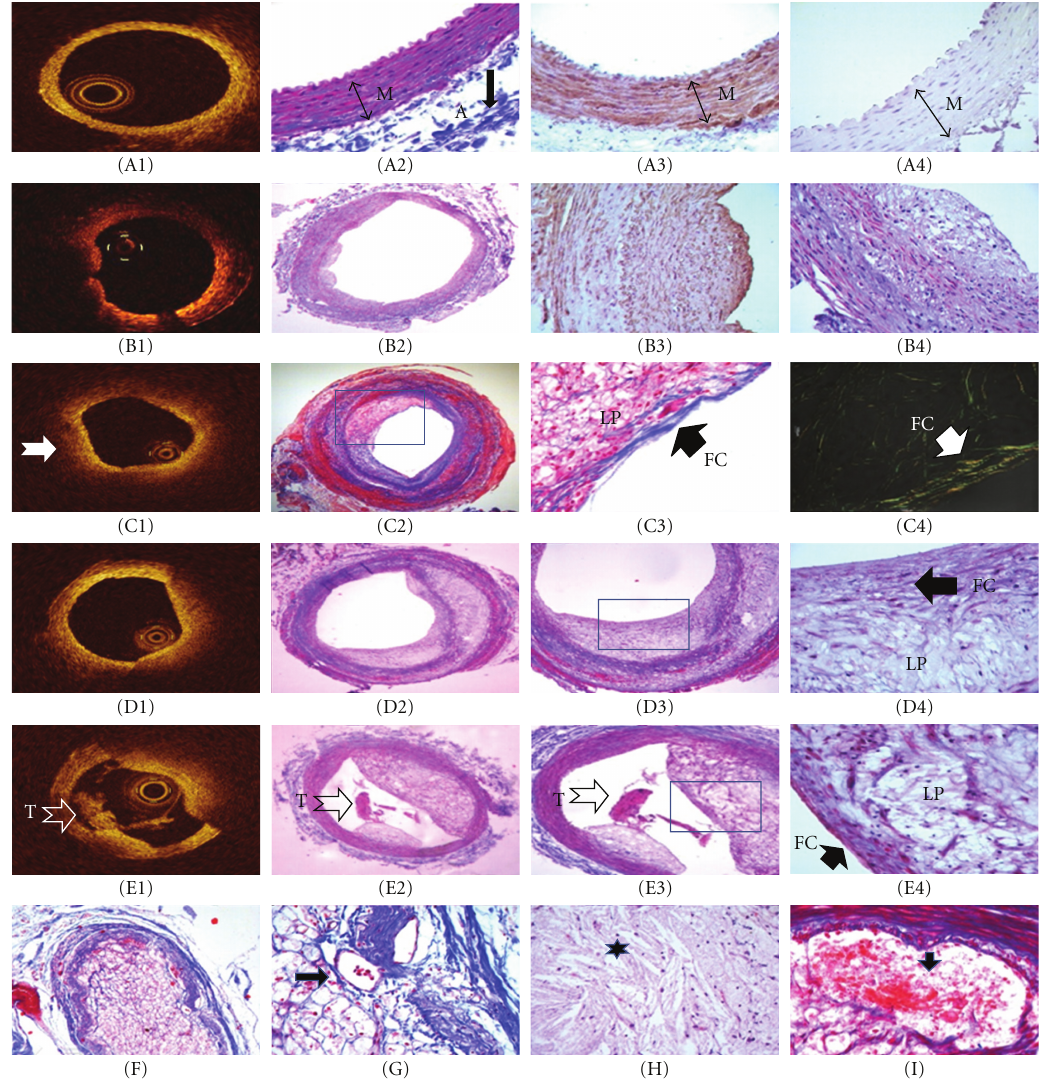
Figure 3: Histological features of normal and atherosclerotic lesions in rabbits and the corresponding OCT images. (A1)–(A4): OCT and histology images of a normal vessel; (B1)–(B4): type-III plaque; (C1)–(C4): type-IV plaque. D1–D4: type-V plaque; (E1)–(E4): type-VI plaque; (F): lesion showing chronic total occlusion (CTO). The lumen is full of foam cells and lipid components; (G): medial neovessels in lesions with CTO. The neovessels (arrow) run longitudinally and contain red blood cells (RBCs). (H): A cholesterol crystal in a type- Va plaque. The cholesterol crystal looks like a spindle and accumulates into one part of the necrotic core; (I): intraplaque hemorrhage. RBCs have accumulated in the lipid pool. Staining is by Masson’s trichrome (A2, B2, B4, C2, C3, D2–D4, E2–E4, and F–I), smooth muscle cell α -actin immunohistochemisty (A3 and B3), macrophage immunohistochemical identification (A4), and Picrosirius Red viewed under polarized light (C4). Original magnification of B2, C2, D2, and E2 is × 40; (A2)–(A4), (D3), (E3), and (F) is × 100. (B3), (B4), (C3), (C4), (D4), (E4), and (G)–(I) is × 400. M denotes the media; A, adventitia; FC, fibrous cap; LP, lipid pool; T,